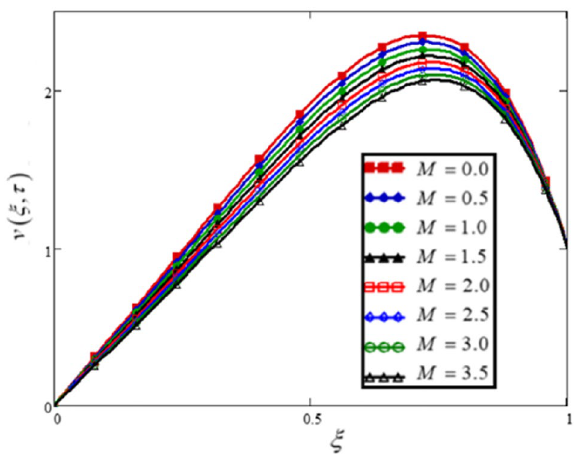
Figure 5. The flow velocity of a Brinkman-type hybrid nanofluid is affected by the Hartman number.